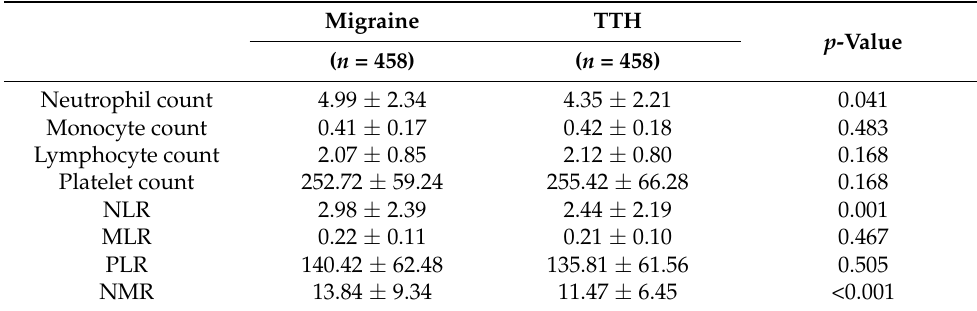
Table 7. Peripheral inflammatory markers of the migraine and TTH groups after